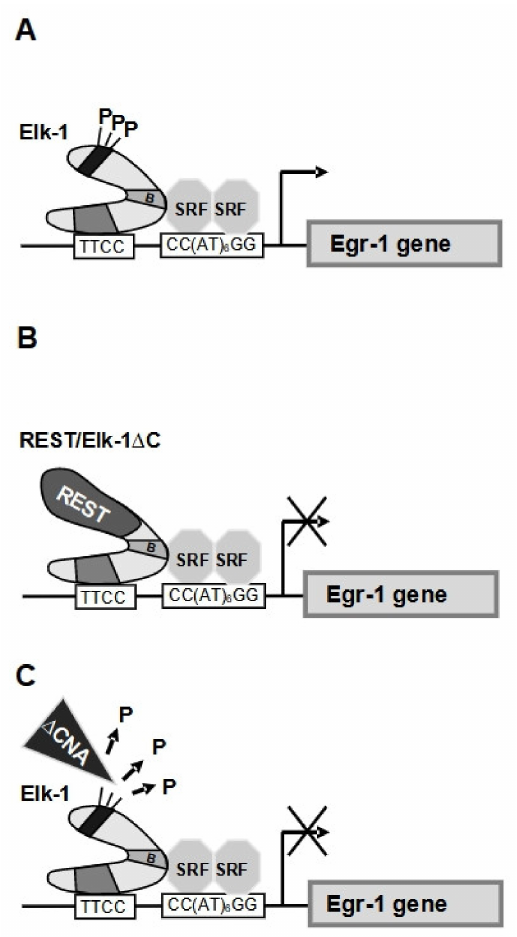
Figure 7. Orchestrated activities of calcineurin, Elk-1 and Egr-1 in pancreatic β -cells regulating islet size, apoptosis and glucose homeostasis. ( A ) The gene encoding the transcription factor Egr- 1 contains five serum-response elements (SREs) that serve as binding sites for Elk-1 and serum response factor (SRF). Transgenic mice expressing a constitutively active mutant of Egr-1, that interferes with Egr-1-regulated gene transcription in pancreatic β -cells, showed a phenotype with reduced islet size, impaired glucose tolerance and increased caspase-3 activity. ( B ) A similar phenotype was obtained in transgenic mice expressing a dominant-negative mutant of Elk-1. This mutant, named REST/Elk- 1 ∆ C, inhibits expression of SRE-regulated genes, including the Egr-1-encoding gene. ( C ) Expression of a constitutively active mutant of calcineurin in pancreatic β -cells generated a similar phenotype. Calcineurin dephosphorylates and inactivates Elk-1. Reproduced with modifications from ref. [84] with permission from